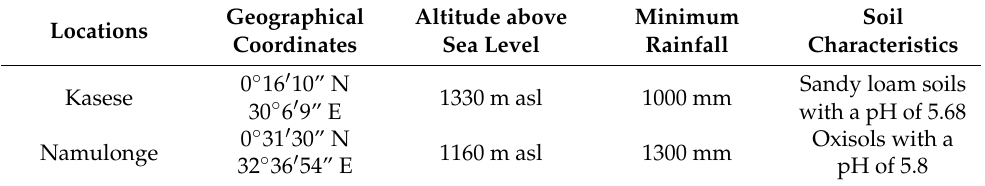
Table 1. Geographical, climatic, and soil characteristics of the planting locations [74]. Geographical Locations Coordinates